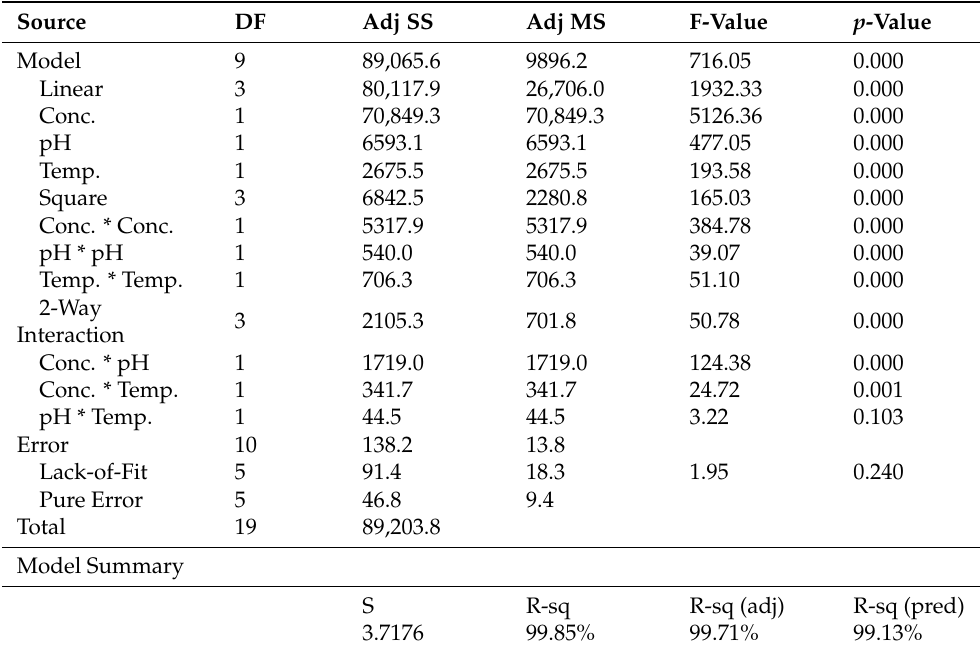
Table 4. ANOVA for response surface quadratic model.